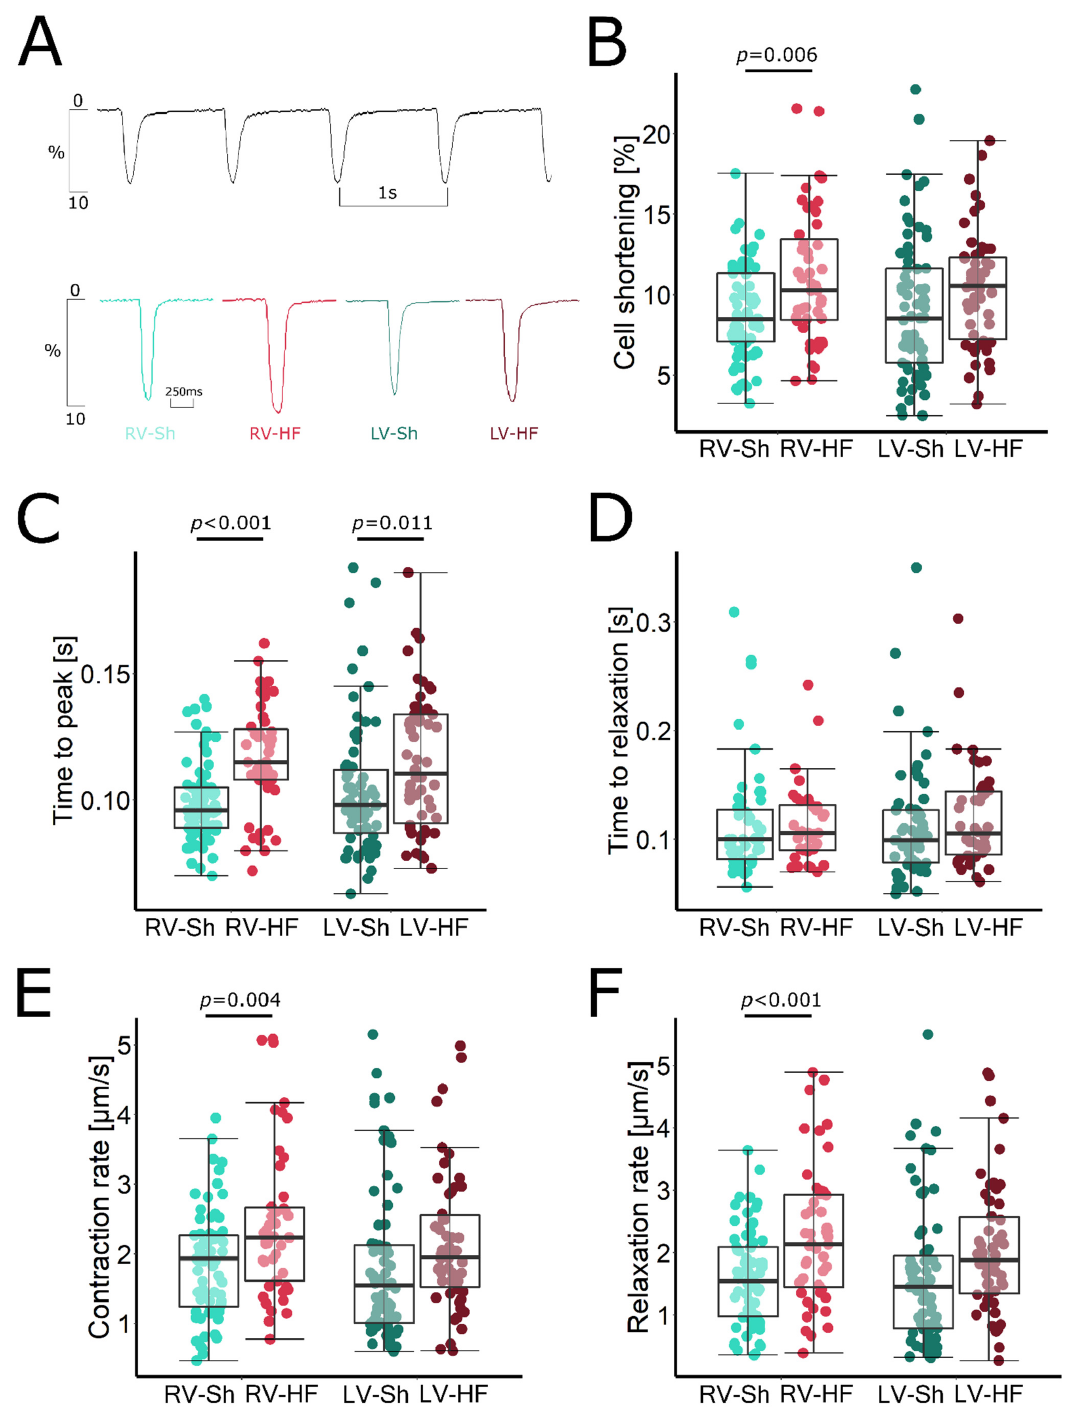
Figure 4. Contractile function of cardiomyocytes isolated from LV and RV of sham-operated (Sh) and heart-failure (HF) rats. ( A ) Representative recordings of sarcomere shortening, ( B ) amplitude of sarcomere shortening, ( C ) time to peak contraction, ( D ) time to 90% of relaxation, ( E ) contraction rate, ( F ) relaxation rate. Data presented as median, Q1, Q3, max and min values, n = 10–20 cardiomyocytes per heart, 5 hearts per